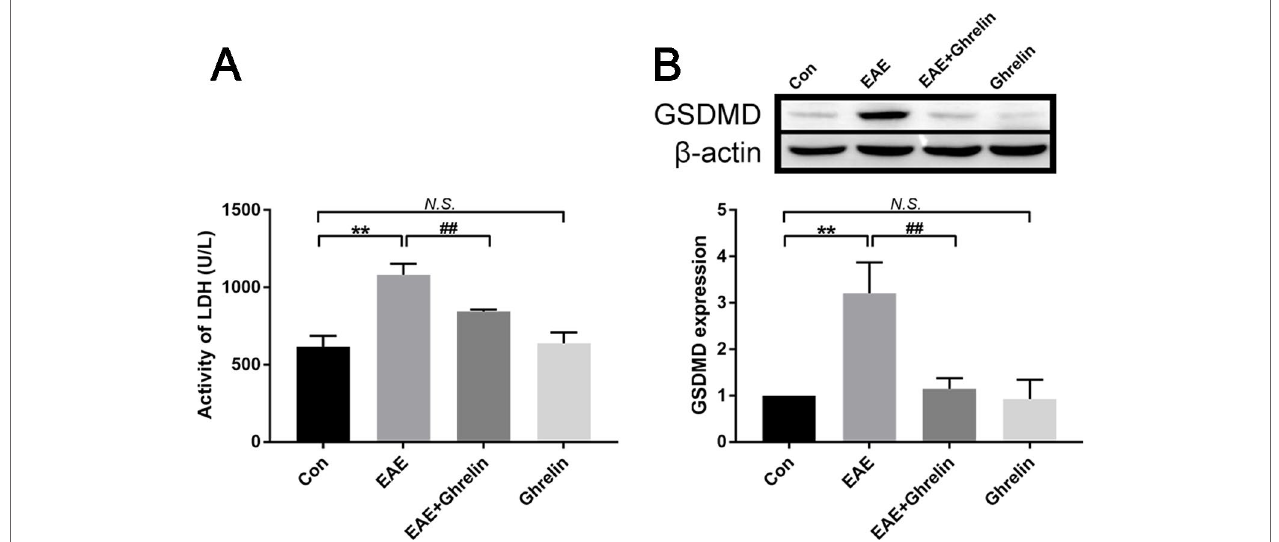
FIGURE 6 | Treatment of ghrelin inhibited pyroptosis in EAE rats. (A) Expression of LDH in serum was measured by an LDH assay kit, n = 10. (B) Representative western blot image of changes in the expression level of GSDMD. β-Actin was used as internal control to calculate relative expression ( n = 5). Data were shown as